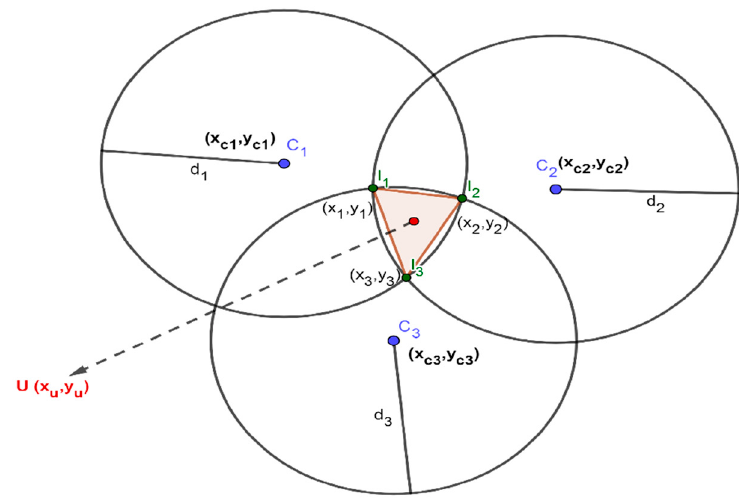
Figure 3. A schematic diagram of the triangle centroid localization algorithm [24–27].